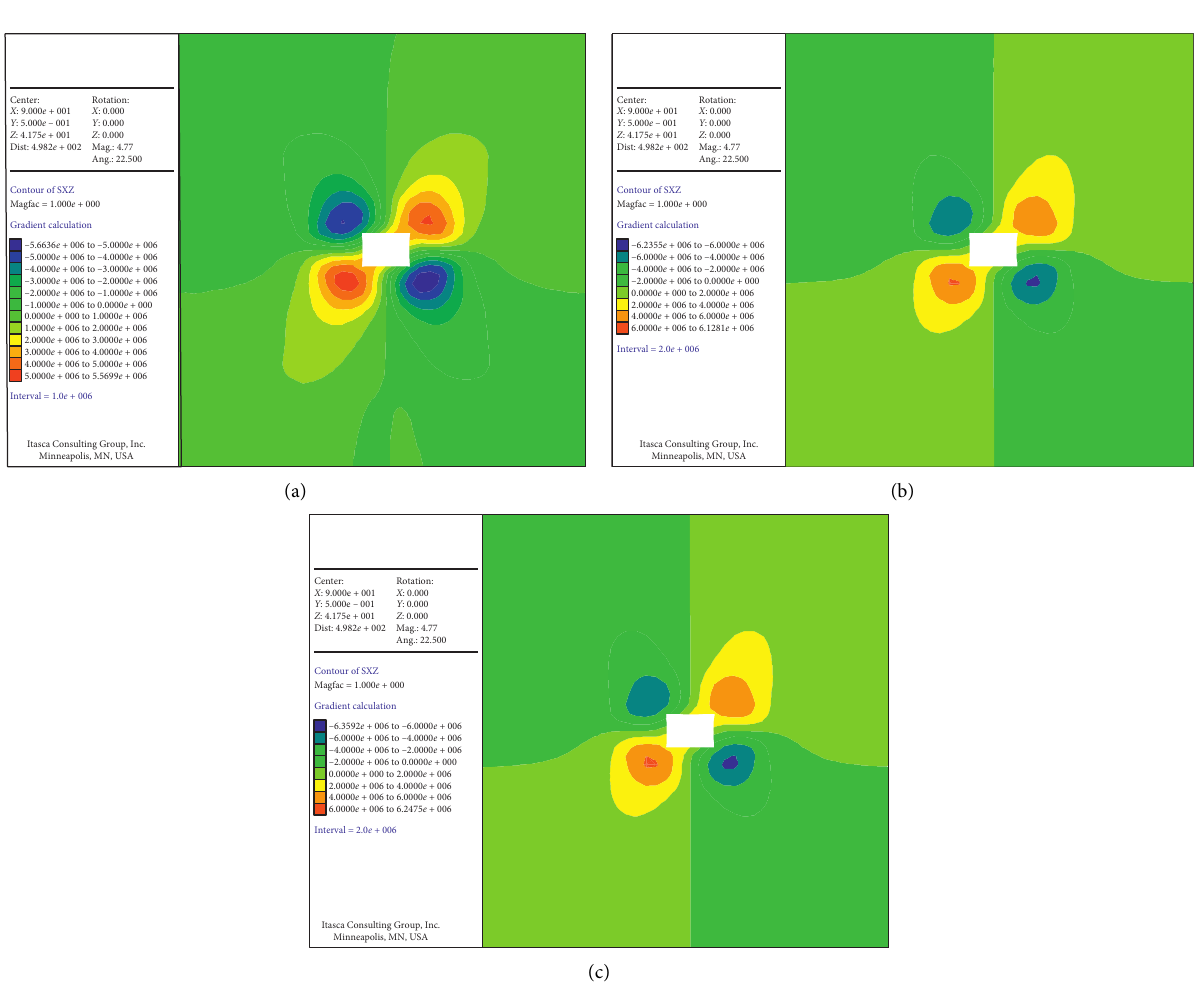
Figure 10: Cloud diagram of shear stress. (a) 300 step; (b) 600 step; and (c) 2100